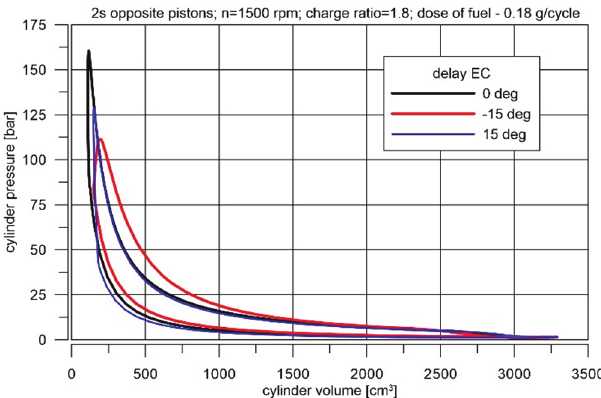
Fig. 13. P-V diagram for different delay of exhaust ports closing (EC)